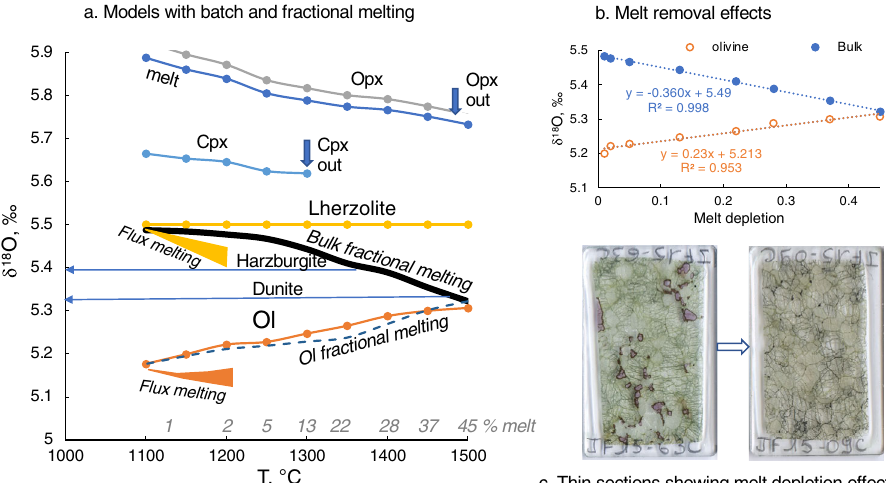
Fig. 3 Computed isotope effects of batch (continuous lines) and fractional (dashed lines) peridotite melting from 0 to 45 ‰ on the equilibrium isotope values of melt and the residual mineral assemblage. a Isotope effects on minerals and the residual bulk. Starting composition at low-T has 56% olivine, 26% Opx, 15% Cpx, and 3% of Spinel. Isotope fractionation factors are from refs. 62,63 . For melt, we assumed A = 1.3. Isotope effects are computed against phase change and proportions (% melt) trends observed in ref. 64 in their peridotite melting experiments, also modeled in ref. 65 in pMELTS. Fractional melting assumed the removal of equilibrium fractional melt shown on the diagram. Flux melting trends are computed using Rayleigh melting by water fl uxing and up to 5% fractional melt removal with shown effect on bulk peridotite and residual olivine δ 18 O values. In this case, it is assumed that water fl uxing generates silica-rich andesitic hydrous melt/ fl uid with δ 18 O = 6.1 – 7.3 ‰ in equilibrium with the ambient assemblage. The upper bound of the fl ux melting triangle is computed by assuming decreasing δ 18 O from 7.3 ‰ to 6.1 ‰ , while the lower bound assumes that the hydrous melts maintain a constant high δ 18 O = 7.3 ‰ . Notice that melt depletion results in lowering bulk δ 18 O, but it also results in higher modal olivine and the δ 18 O Ol values which are higher (closer to the bulk), while δ 18 O Opx is also higher; Δ 18 O Opx-Ol are constant. b effect of melt depletion along the melting path shown in ( a ) for δ 18 O Ol or δ 18 O δ 18 O δ 18 O δ 18 O δ 18 O bulk . Notice the nearly linear change. Upon melt extraction, dunite < harzburgite < lherzolite . cooling will not affect bulk (blue horizontal lines) but will increase Δ 18 O mineral-mineral . fractionation as is shown. c Thin sections of samples showing enriched and depleted harzburgites that lost melt, and the fi nal residual assemblage is olivine-richer. The horizontal width is 3